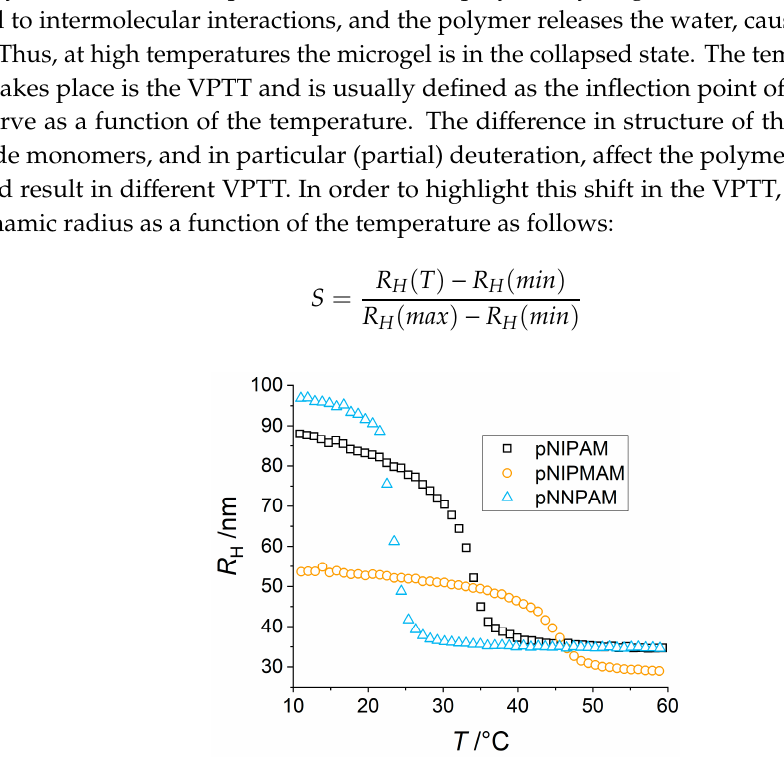
Figure 2. Hydrodynamic radius of pNNPAM (1.9 mol% BIS), pNIPAM (5.0 mol% BIS), and pNIPMAM (10.0 mol% BIS) as a function of the temperature. The curves were measured in water for particles synthesized under identical conditions.